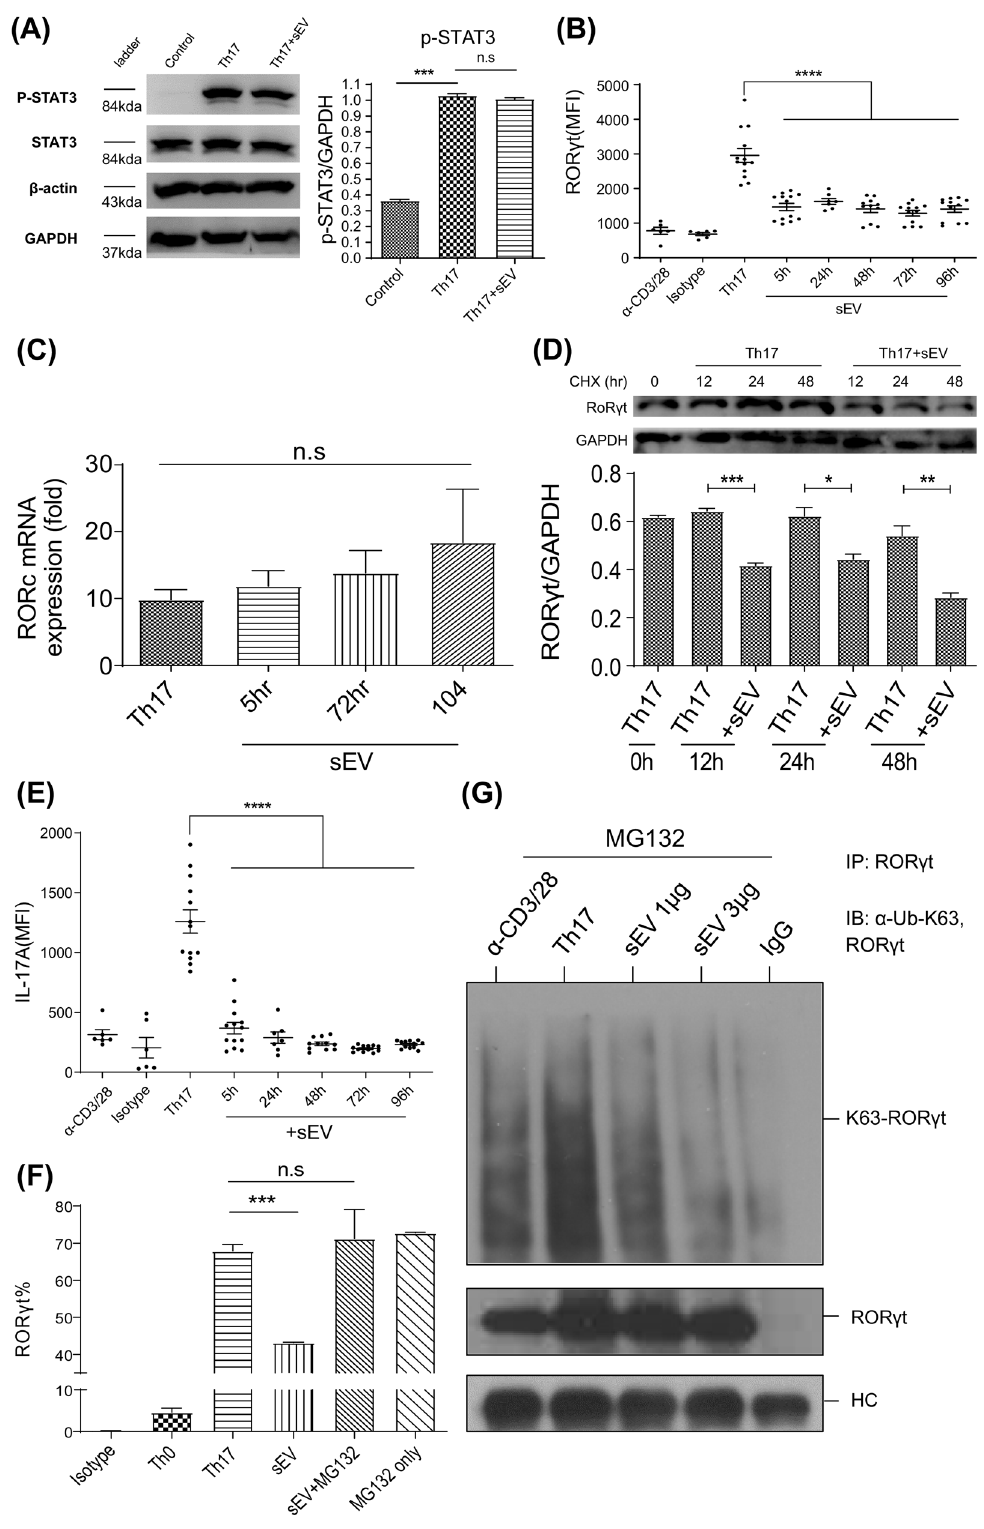
As shown in Fig. 5G, the spleen and draining lymph nodes were enlarged in the EAE-induced mice compared to the wild-type mice. However, the size of these organs in the EAE-induced mice treated with MSC-sEVs remained similar to that of wild-type mice. FACS analysis of the lymphocytes in the draining